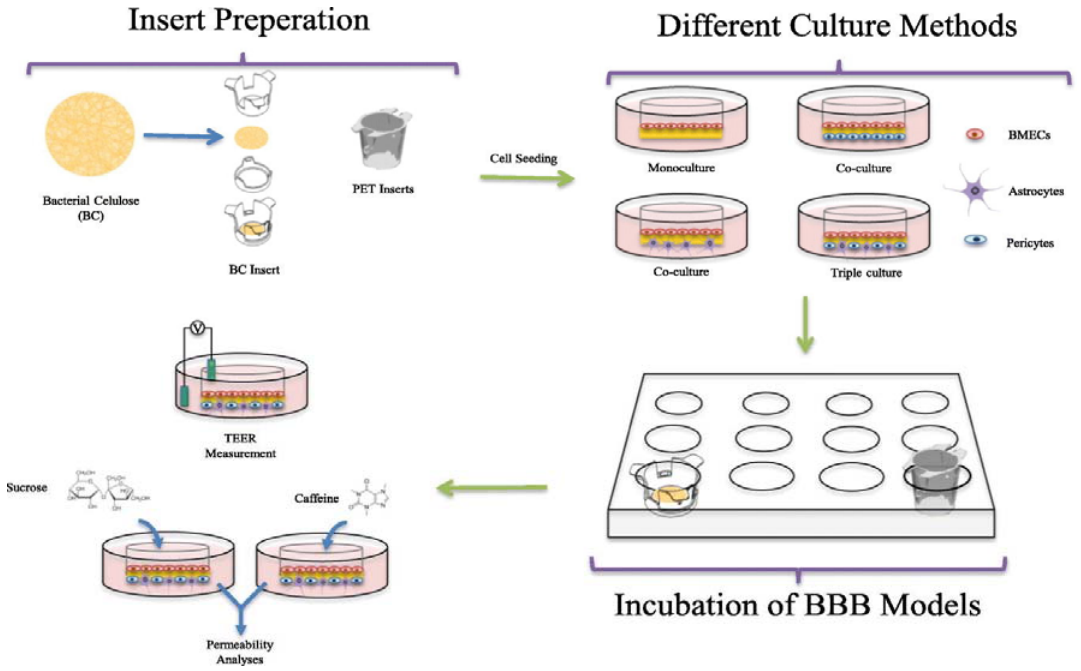
Figure 6. BC used as basement membrane in BBB model. Reprinted with permission from [99]. Copyright (2019) Elsevier.